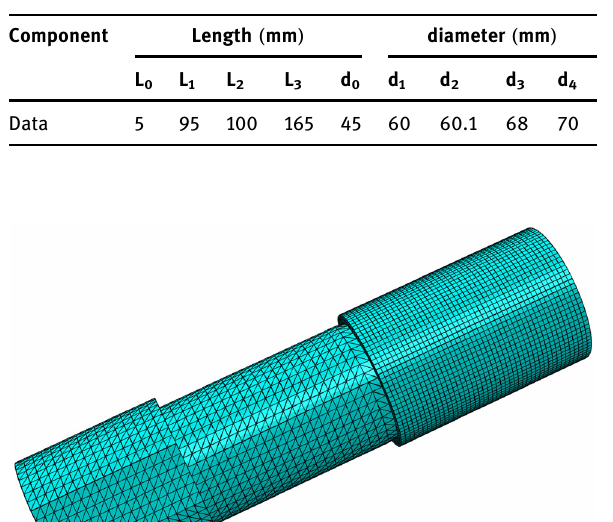
Table 3: Shape size used in FEA model